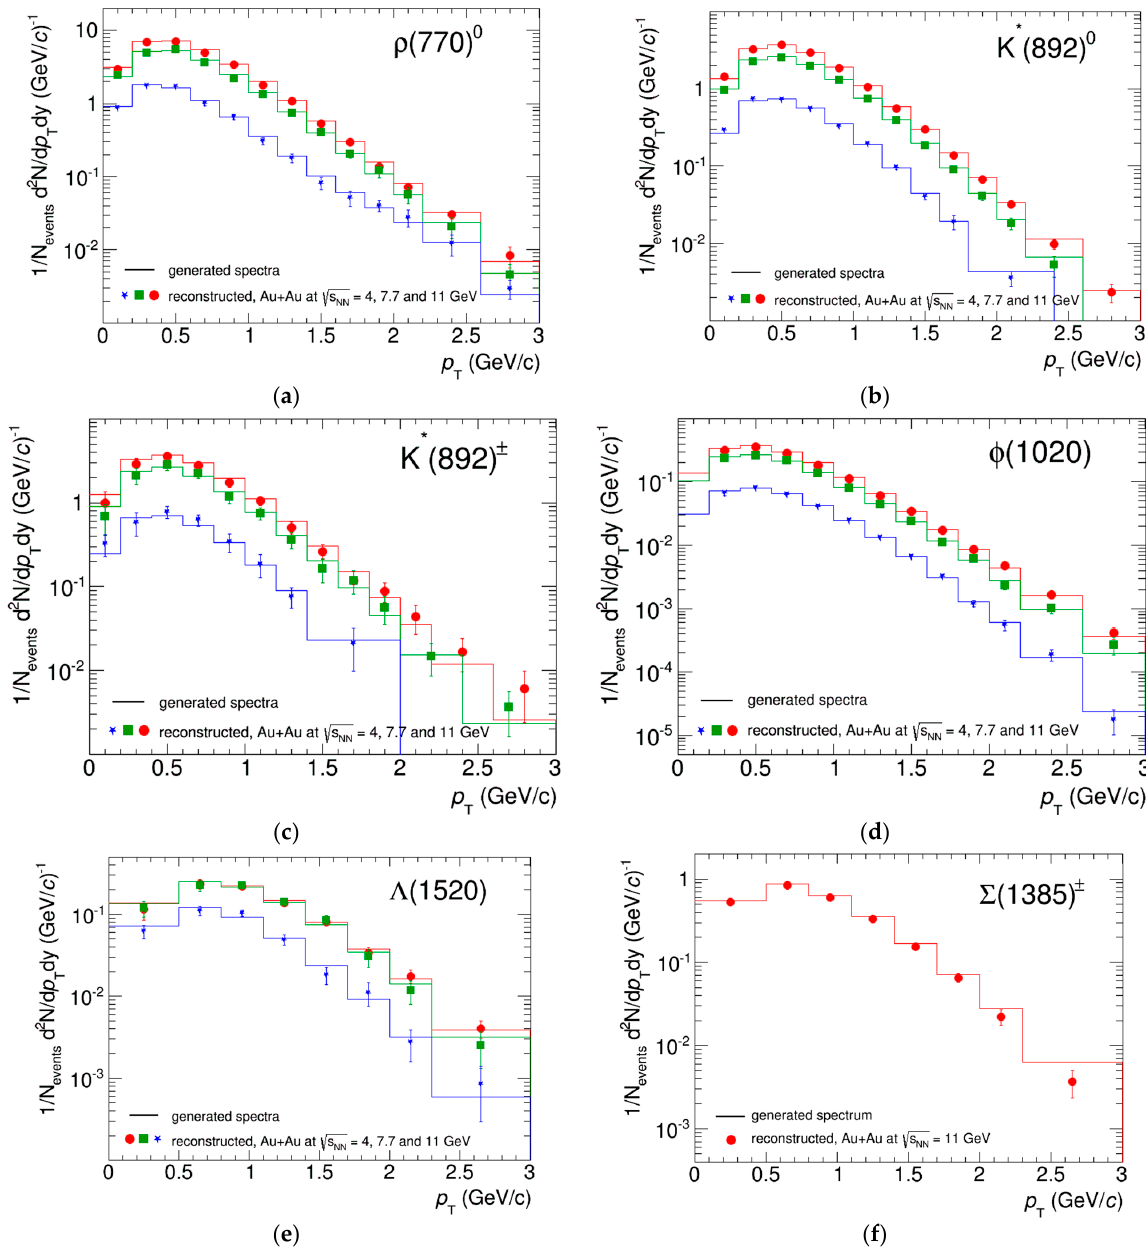
Figure 5. Transverse momentum spectra reconstructed in Au+Au collisions at √ 𝑠 𝑁𝑁 = 4, 7.7 and 11 GeV are shown with markers of different colors and compared to truly generated spectra shown with solid lines of the same color for ρ (770) 0 ( a ), K*(892) 0 ( b ), K*(892) ± ( c ), ϕ (1020) ( d ), Λ (1520) ( e ) and Σ (1385) ± ( f )